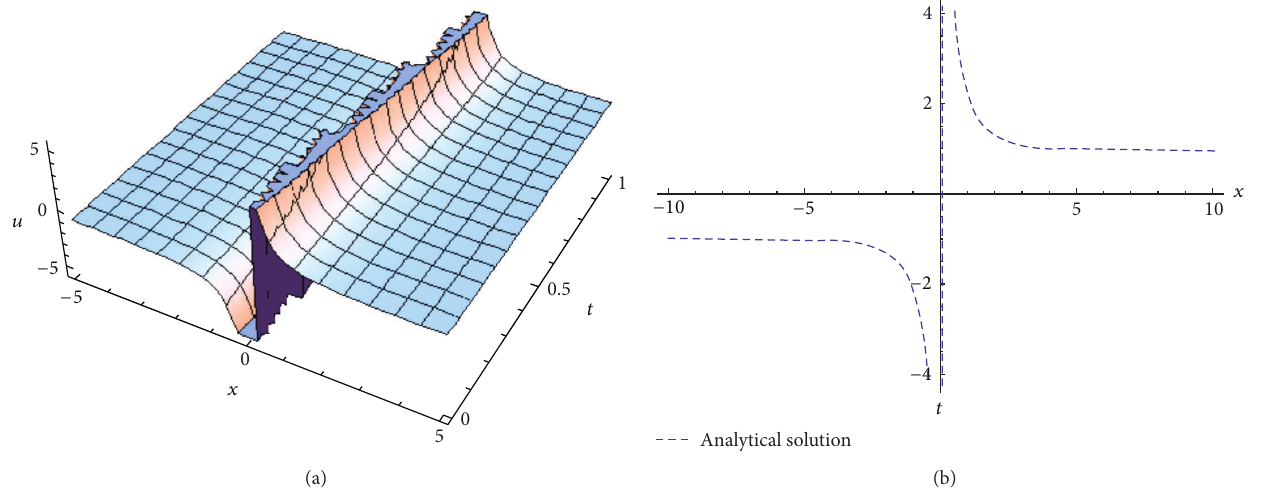
Figure 2: The solution (39) is shown at 𝑘 = 𝑤 = 1 , and the second graph represents the exact analytical solution of (39) for 𝑡 = 0.5